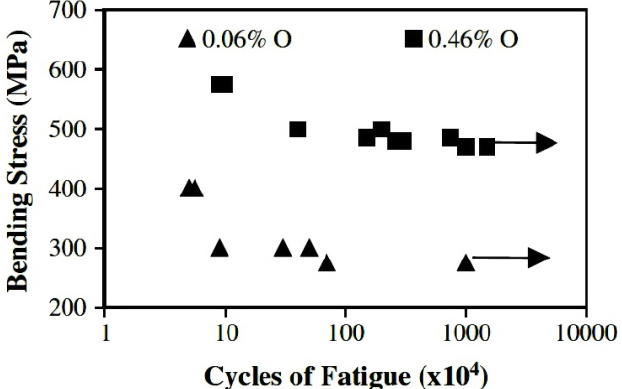
Figure 11. Stress-controlled fatigue response for Ti-35Nb-7Zr-5Ta with two different oxygen contents [155]. Reprinted with permission from [155]. Copyright 1999